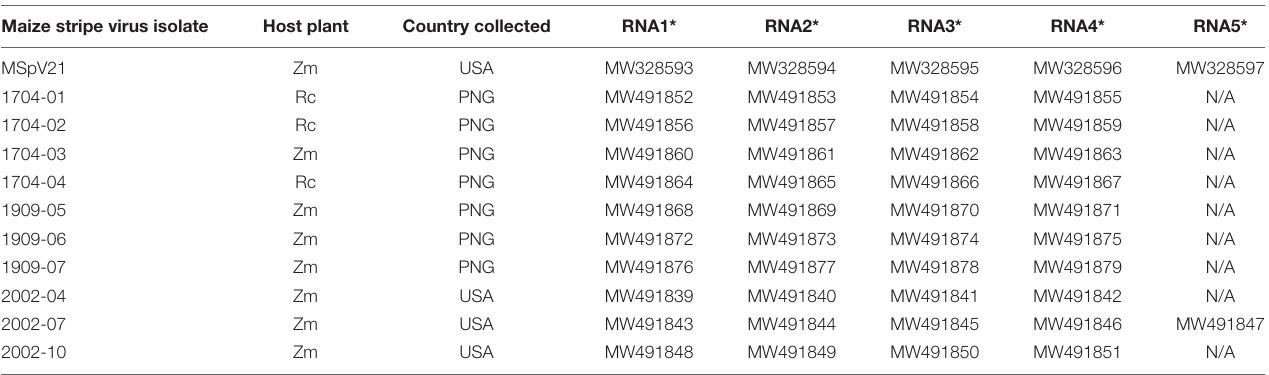
TABLE 1 | Depository information for maize stripe virus isolates. Maize stripe virus isolate Host